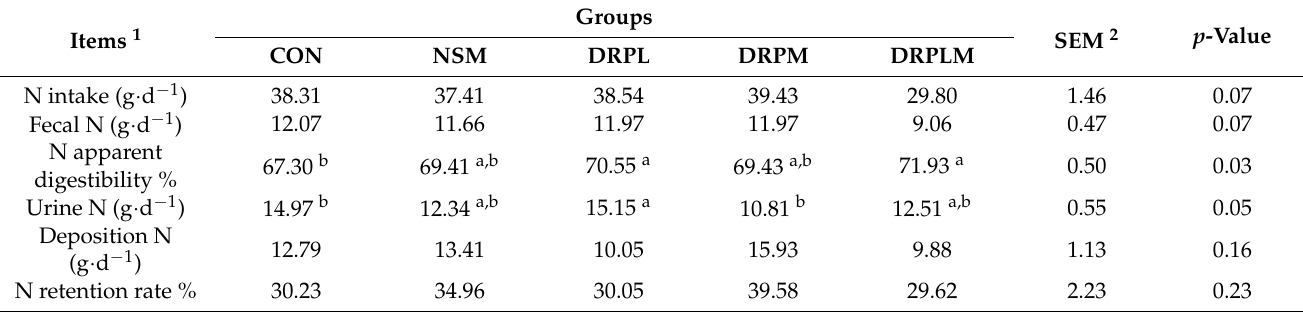
Table 6. Effects of dietary supplementation with rumen-protective amino acids on nitrogen metabolism in Hu sheep.